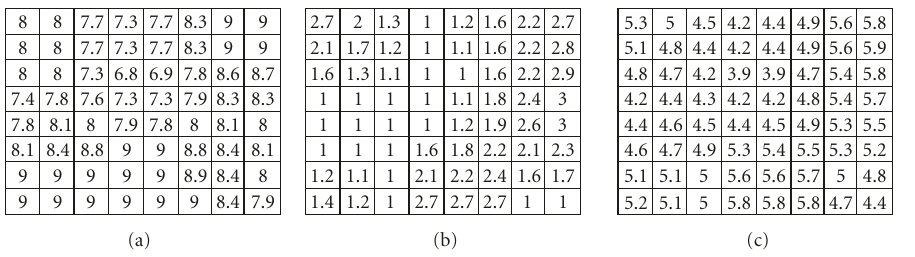
Figure 4: For data matrix of Figure 1(a): (a) upper envelope matrix using FABEMD after smoothing, (b) lower envelope matrix using FABEMD after smoothing, and (c) mean envelope matrix obtained by averaging the data in (a) and (b).